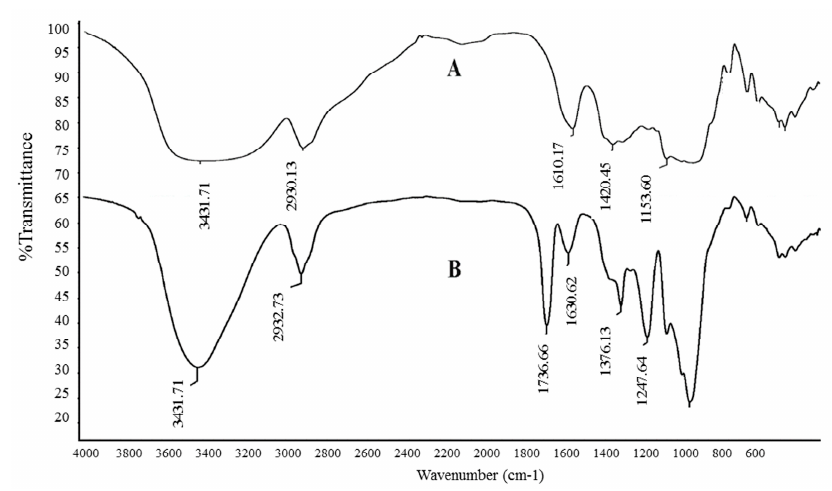
Figure 1. ( A ) Fourier transform infrared (FTIR) spectra of JCS1 and ( B ) acetylated derivative YJCS1.